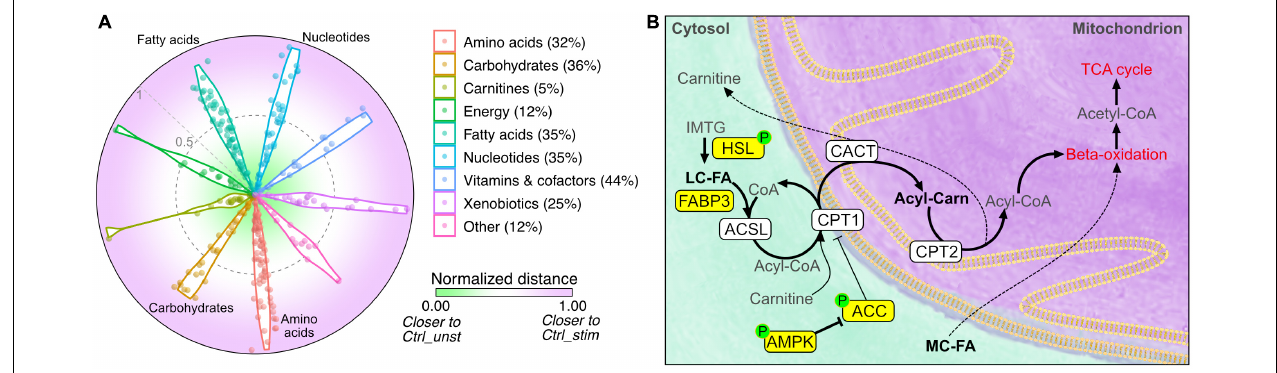
FIGURE 7 | Comparison between unstimulated Il15ra − / − and stimulated controls. (A) Radar chart representation of the Euclidean distance between unstimulated Il15ra − / − , unstimulated control muscle and stimulated control muscle for the metabolites in each superclass. Values were rescaled to a range from 0 (close to unstimulated control) and 1 (close to stimulated control). Percentage number indicate the ratio of metabolites in Il15ra − / − muscle that were similar to stimulated control. (B) Diagram summarizing the effects of lack of IL15RA on muscle fatty acid metabolism. Yellow nodes indicate enzymes significantly upregulated/activated in Il15ra − / − muscle, according to previous publications by our group (Loro et al., 2015, 2018). Thick arrows represent metabolic reactions that are enhanced in Il15ra − / −